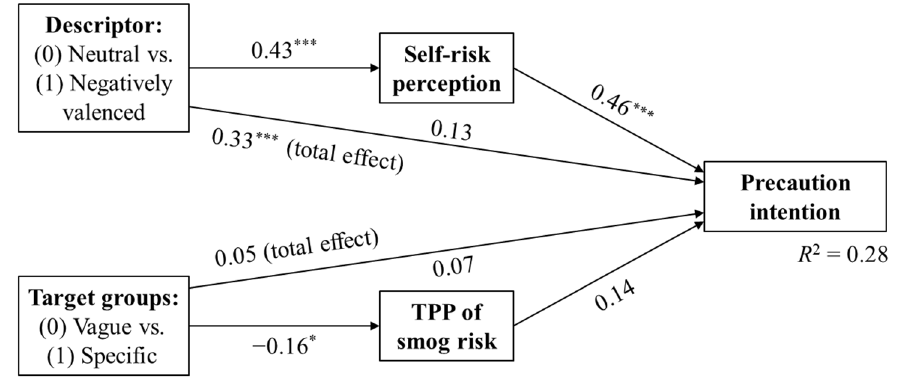
Figure 2. Path model results. Note: *p < 0.05 (significance level), ** p < 0.01, *** p <